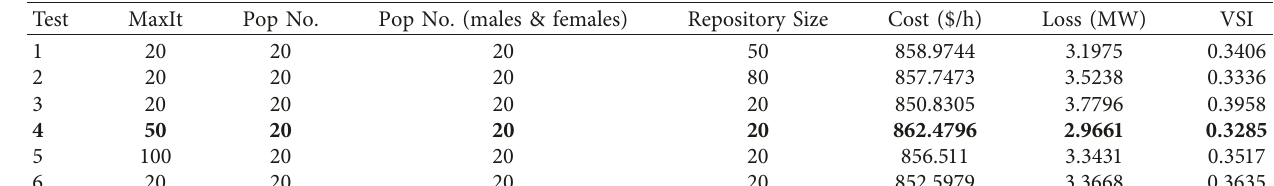
Table 6: Parameter setting for MOMA.